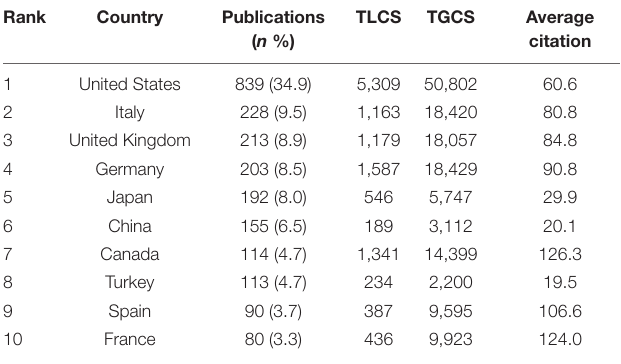
TABLE 1 | The top 10 productive countries concerning uremic